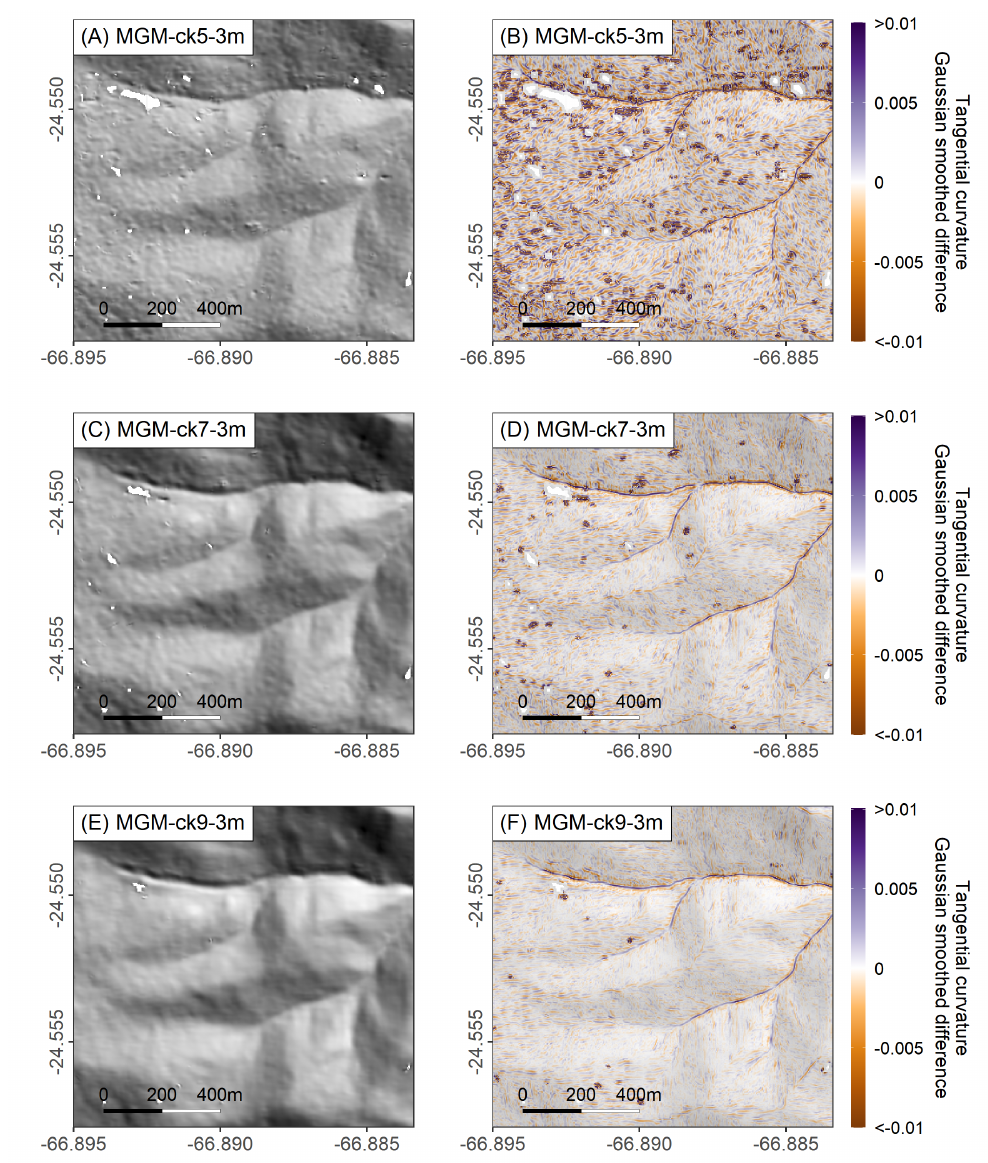
Figure 13. Difference between tangential curvature calculated in a 3 × 3 pixel window and a Gaussian- smoothed version of this curvature map for the MGM DEMs. Same area as is shown in Figure 3 (see Figure 2A for location in study area); ( A ) hillshade of the MGM DEM with a CK of 5 × 5 pixels; ( B ) curvature difference map for this DEM. Larger differences occur in areas with more spiky DEM curvature; ( C – F ) similar pairwise (hillshade and curvature difference) results for the CK 7 × 7 and 9 × 9 pixel MGM